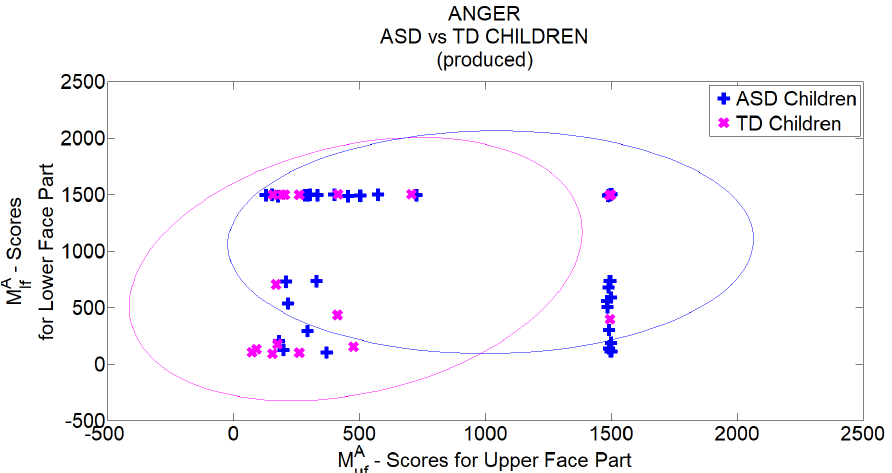
Figure 16. Comparison of the scores computed for the production of Anger expressions by ASD and TD